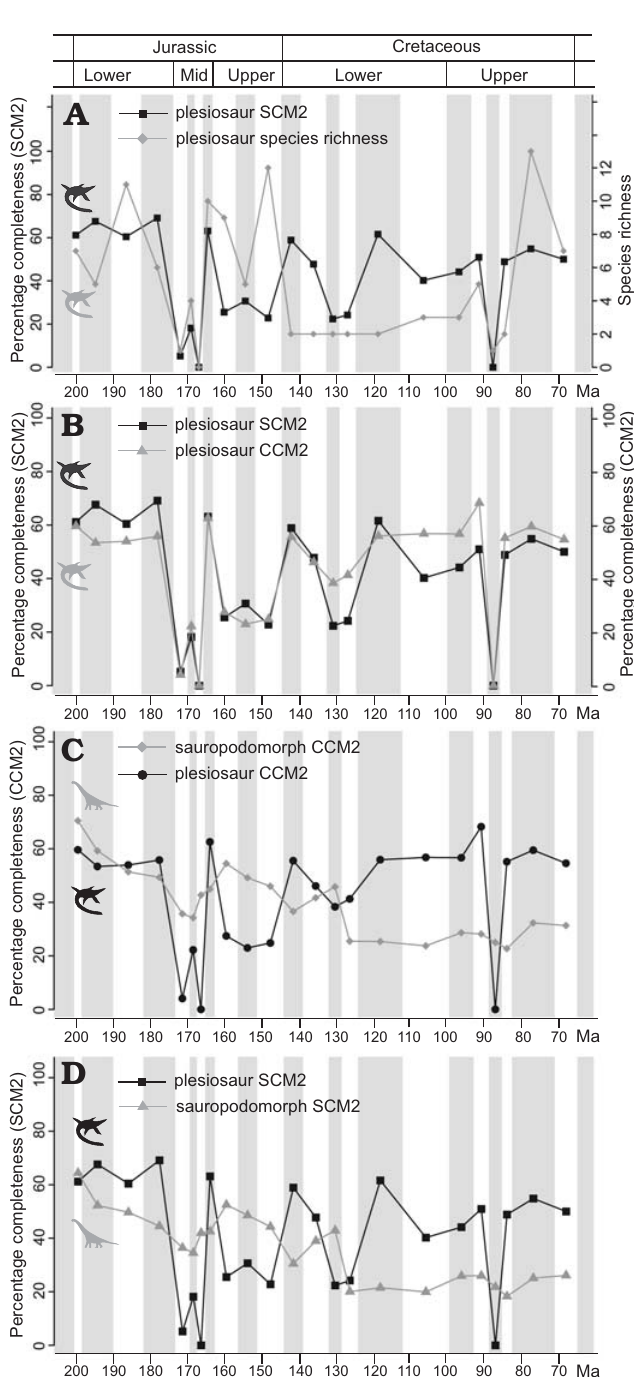
Fig. 2. Changes in skeletal completeness through time. A . Plesiosaur SCM2 and plesiosaur species richness. B . Plesiosaur CCM2 and SCM2. C . Plesiosaur CCM2 and sauropodomorph CCM2. D . Plesiosaur SCM2 and sauropodomorph SCM2. Silhouettes are from phylopic.org, and are credited to Adam Stuart Smith ( Plesiosaurus ) and Scott Hartman ( Brachiosaurus ). Abbreviations: CCM, character completeness metric; SCM, skeletal completeness metric (for detailed explanation of terms see Completeness metrics in Methods